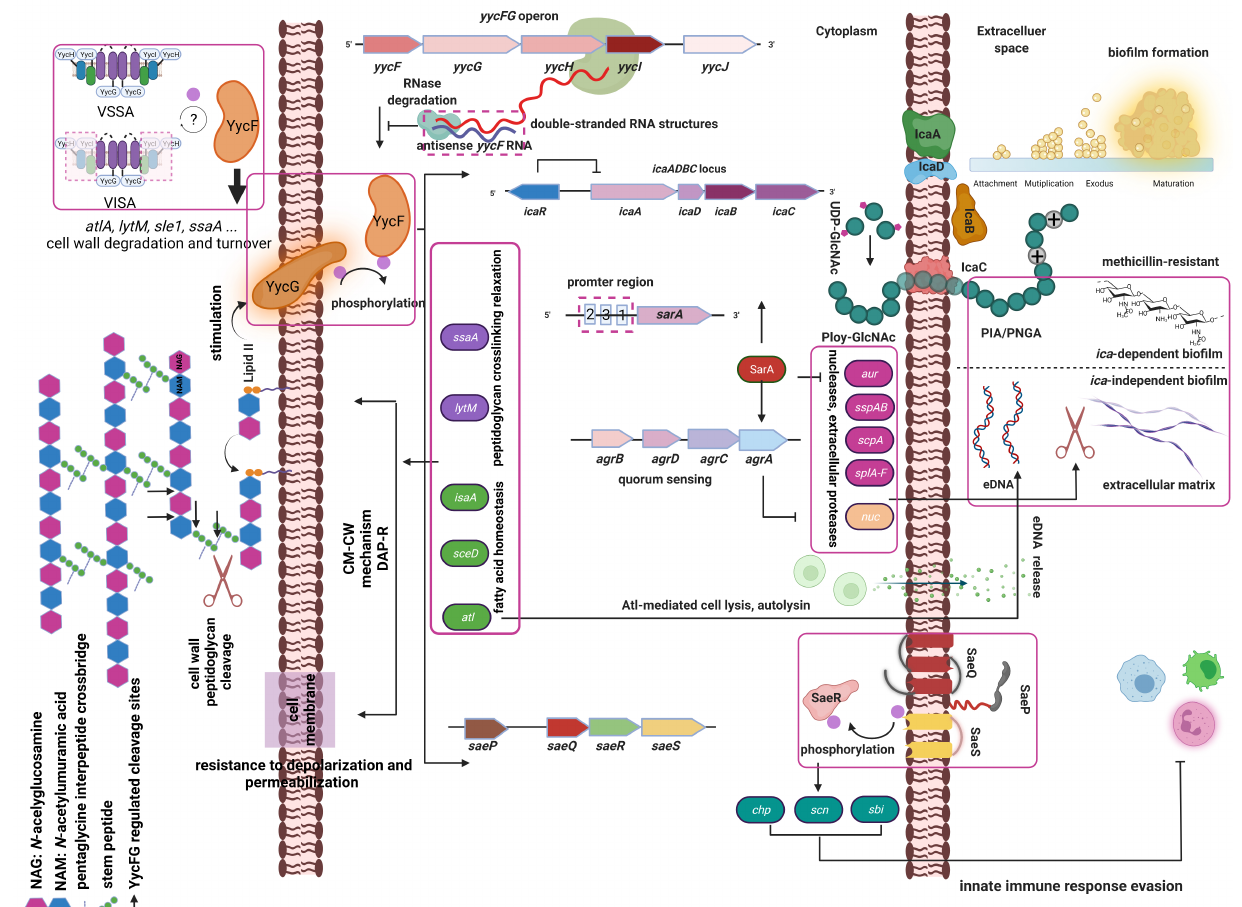
Figure 1. The only essential YycFG two-component regulatory system (TCS) is a large operon that comprises yycFGHIJ and influence antibiotic resistance in S. aureus . YycG is a sensor histidine-kinase compromised by two transmembrane sequences and a periplasmatic loop [37,85]. To sense and respond to specific environmental cues, YycG can auto-phosphorylate and transfer phosphoryl group to its cognate response regulator YycF inducing activities of biofilm formation, susceptibility to antibiotics such as vancomycin and daptomycin and innate immune system evasion. The icaADBC -encoded polysaccharide intercellular adhesin (PIA) or polymeric N-acetyl-glucosamine (PNAG) from UDP-N-acetylglucosamine (UDP-GlcNAc) contributes to ica -dependent biofilm development [16]. Besides ica -dependent biofilm, ica -independent extracellular matrix significantly contributes biofilm formation [86]. eDNA released by the major autolysin of S. aureus Atl in the lysis of bacteria and leads to enhanced biofilm formation [87]. The major global regulators, staphylococcal accessory regulator ( sarA ) is driven by three different promoters (P1, P2 and P3) [88]. SarA is a positive regulator of agr (Accessory gene regulator) quorum-sensing system including four genes, agrBDCA . Under the YycFG TCS control, SarA results in downregulation of proteases and the thermostable nuclease such as aur , sspAB (Staphylococcal serine proteases), scpA (Staphylococcal cysteine protease operon), splA-F (Serine protease-like proteins) and nuc (Thermostable nucleases), allowing for biofilm maturation [76,88]. This biofilm formation causes a relationship with methicillin resistance status [89]. Auxiliary